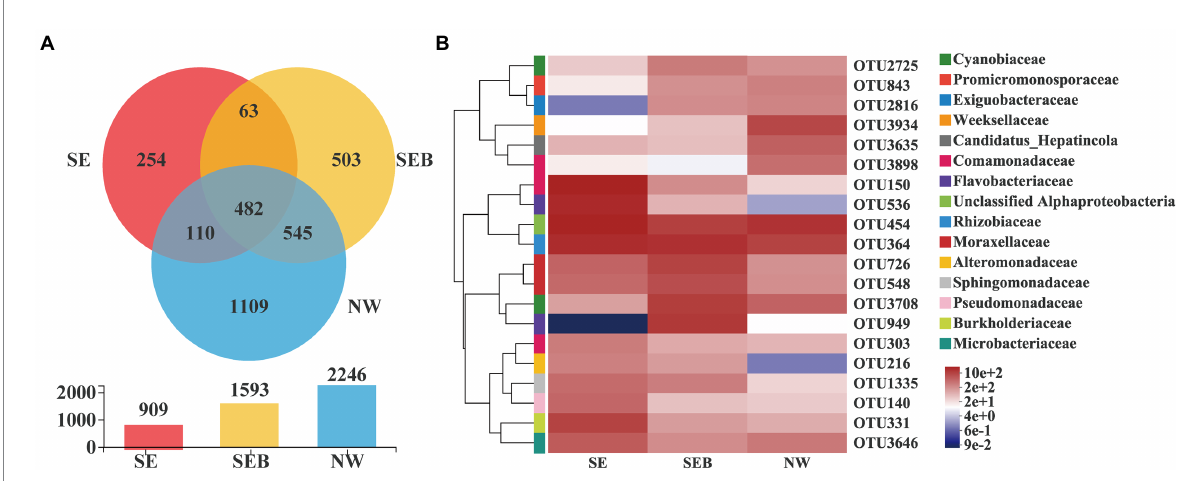
FIGURE 5 Distribution of OTUs in different treatment groups. (A) Venn diagram of OTUs distribution in different treatment groups. Different colors represent different groupings, the numbers of overlapping parts represent the number of species common to multiple groupings, and the numbers of non- overlapping parts represent the number of species unique to corresponding groupings. The bar chart below shows OUTs distribution of each of the three groups. (B) Heatmap of the top20 dominant OTUs in different treatment groups. The abscissa is the group name, and the ordinate is the species name. The abundance changes of different species in the sample are displayed through the color gradient of color blocks. On the right side of the figure, the lower side is the value represented by the color gradient, and the upper color level represents the family to which OUT